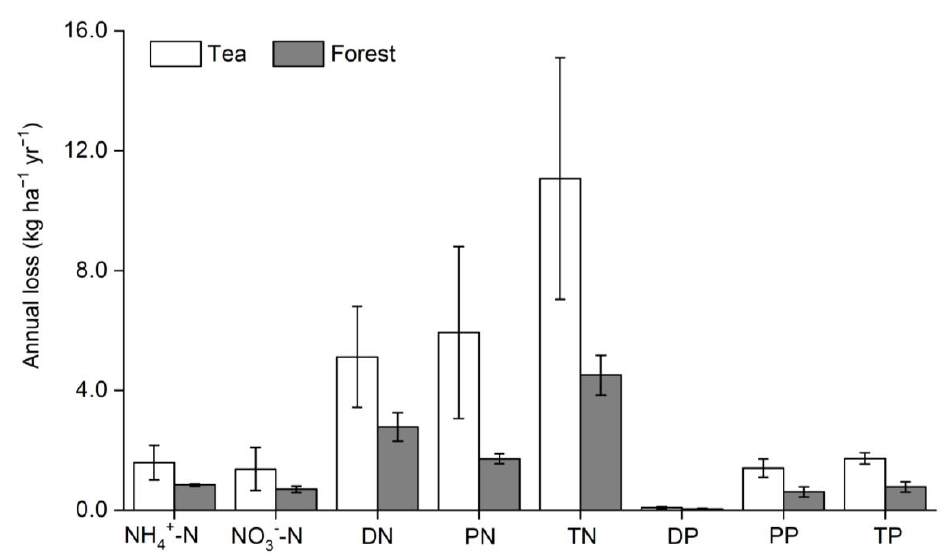
Figure 5. Mean and standard deviation (SD) of the annual nitrogen and phosphorus losses in the tea and forest systems during the observation period from 2013 to 2016.